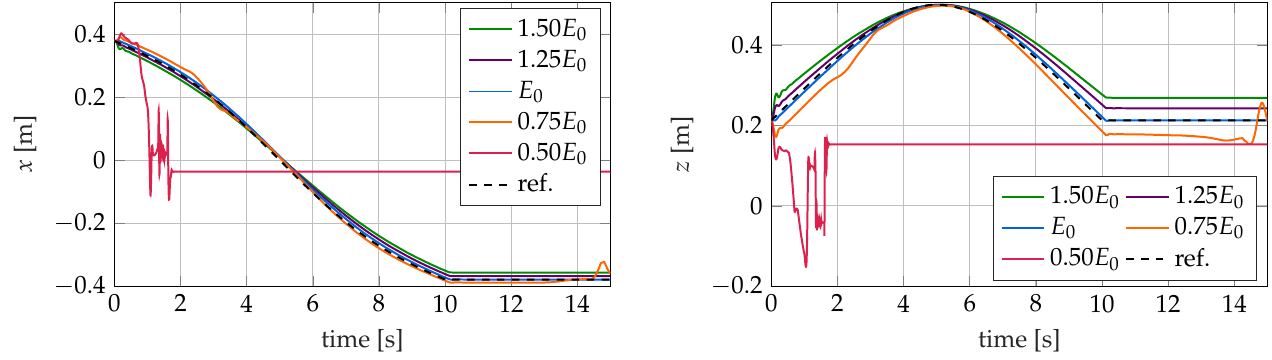
Figure 17. Trajectories of the tip position for the LQRI for different values of the young’s modulus E .